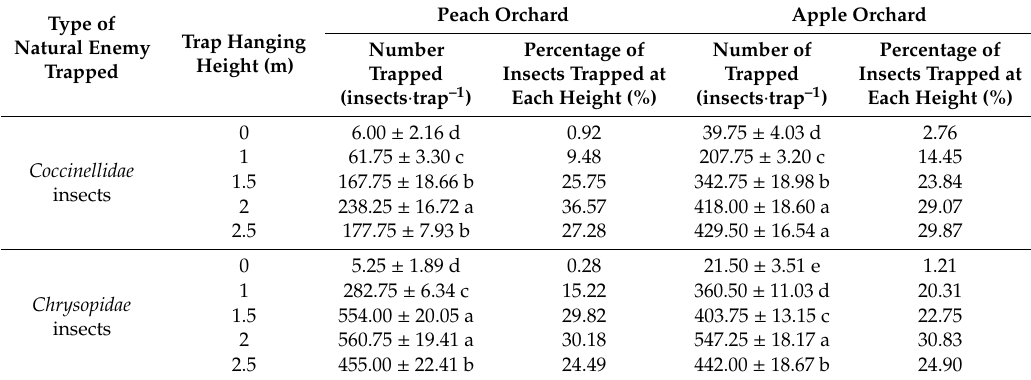
Table 2. E ff ects of trap hanging height on the numbers of Coccinellidae and Chrysopidae trapped by SAEWM-baited traps in Tai’an, China, in